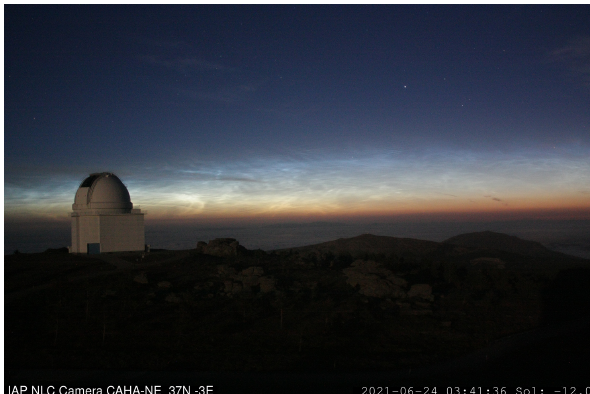
Figure 9. Photograph of NLCs taken by Gerd Baumgarten on 24 June 2021 from Calar Alto,